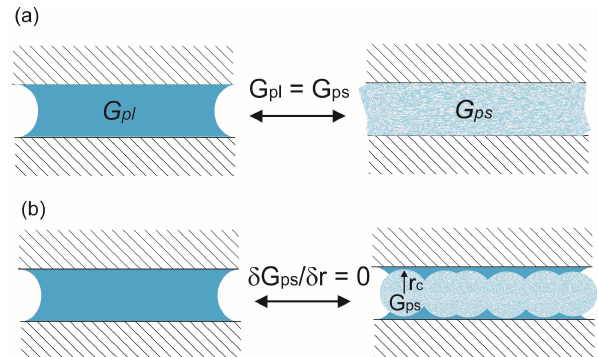
Fig. 4. (a) Scheme representing equilibrium condition between wa- ter phase (left) and ice phase (right) confined in a cylindrical pore as formulated in Eq. (6). (b) Ice crystals limited to critical size in cylindrical pores given by the critical radius ( r c ) derived from